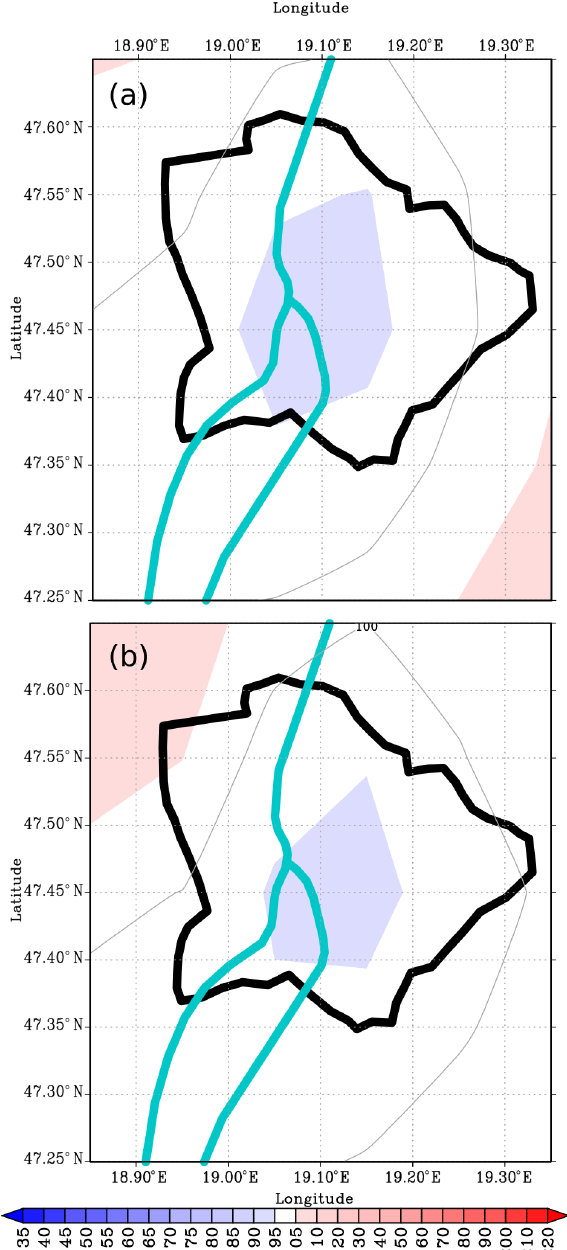
Figure 9. Spatial distribution of median O 3 concentration in Bu- dapest in 2018–2019 (a) and 2020 (b) during the Restriction phase of the first COVID-19 outbreak obtained from CAMS ensemble re- analysis. The concentrations were normalised to the overall spatial median concentrations of 60 and 67µgm − 3 , respectively. The bor- der of the city and the Danube River are indicated with curves in black and blue colours, respectively, for better